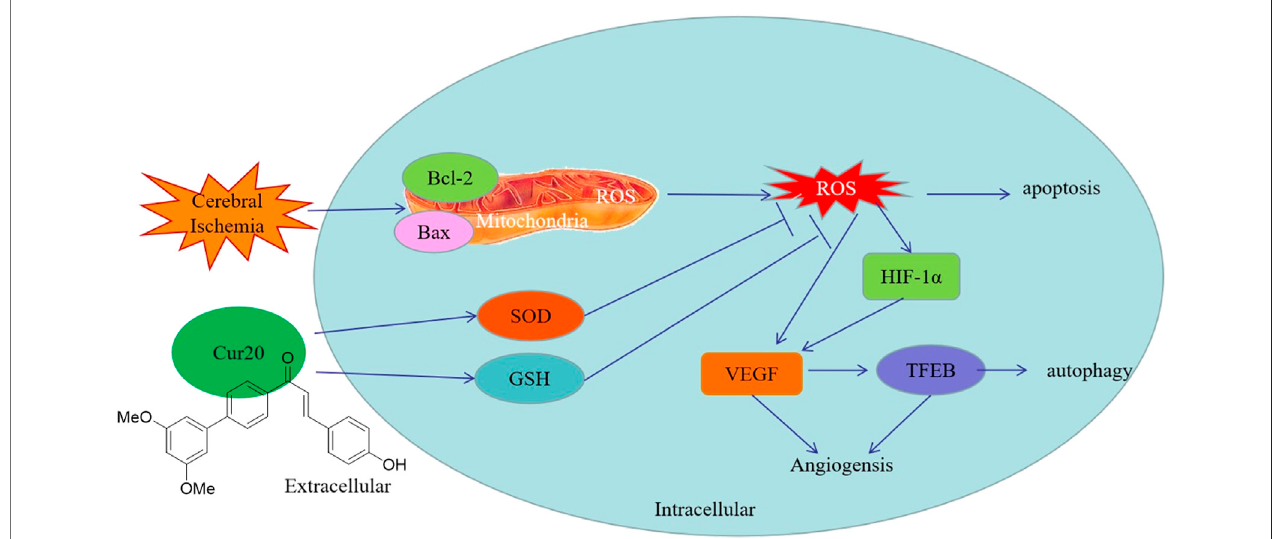
FIGURE 10 | Possible protection mechanism of Cur20 against ischemic injury in